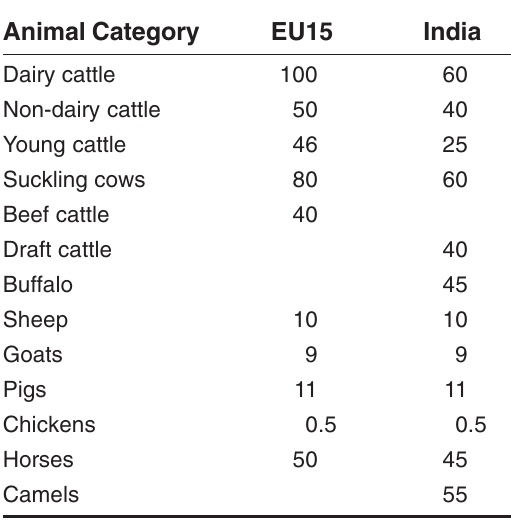
Animal Production in EU15, India, and the World in 1998 Animal Category